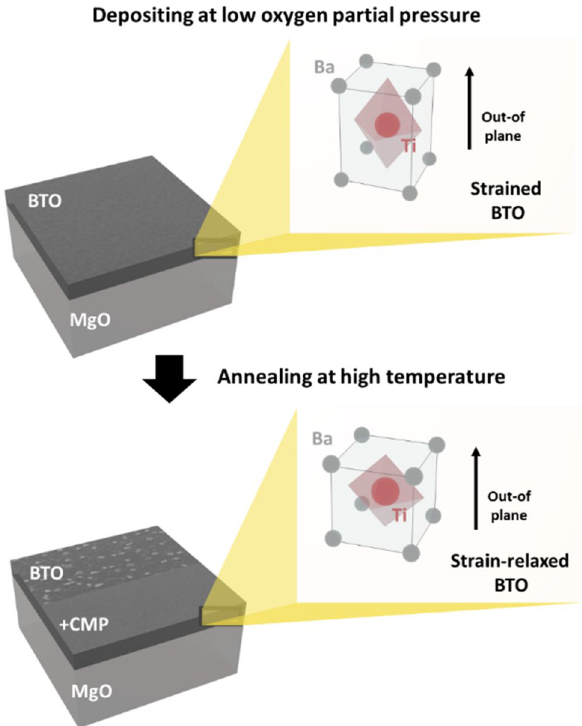
Figure 1. Schematic image of the fabrication of ultra-smooth and strong ferroelectric BTO film by controlling lattice